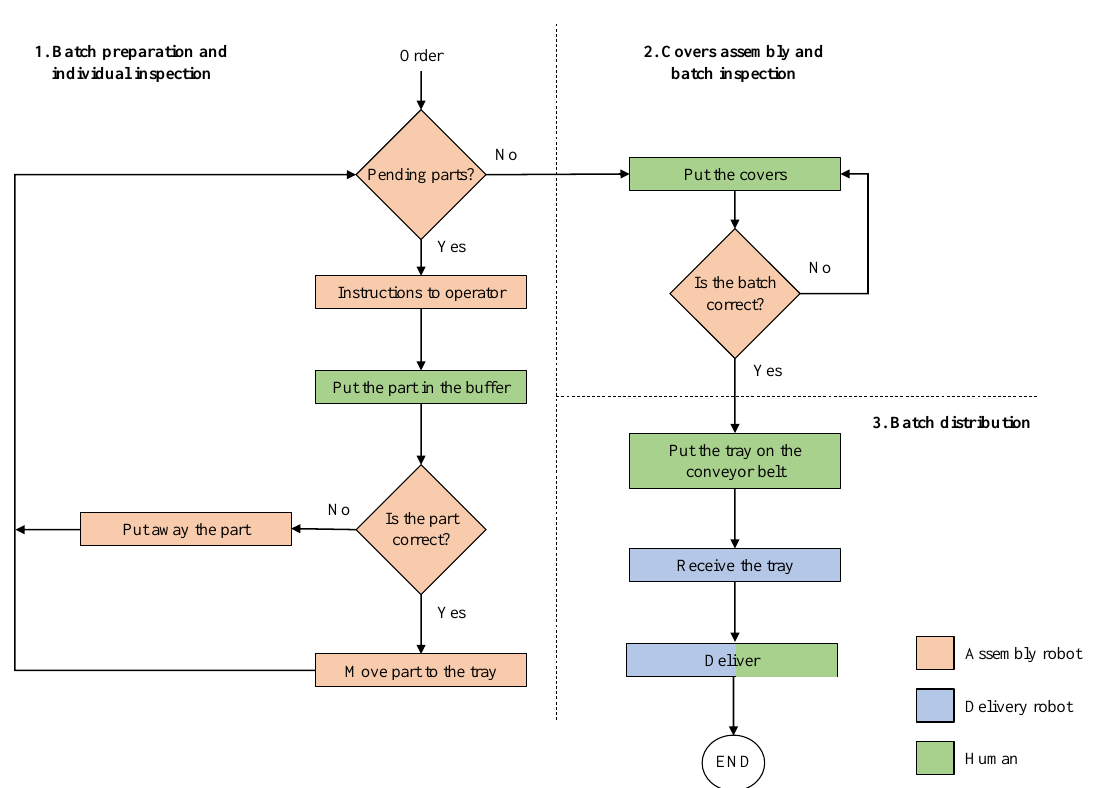
Figure 4. Flowchart of the use case process with the tasks of each key